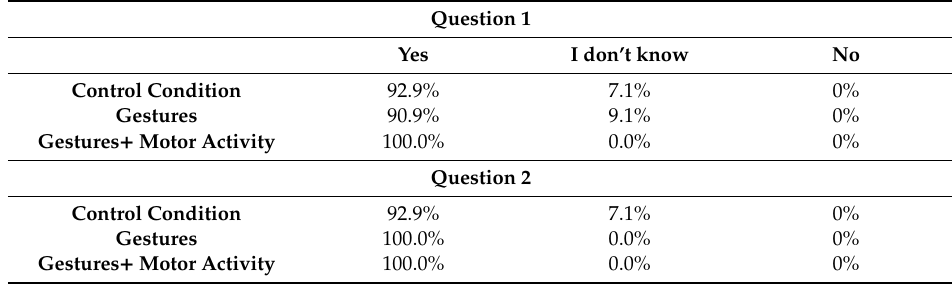
Table 4. The approach used with degree of satisfaction reported by the